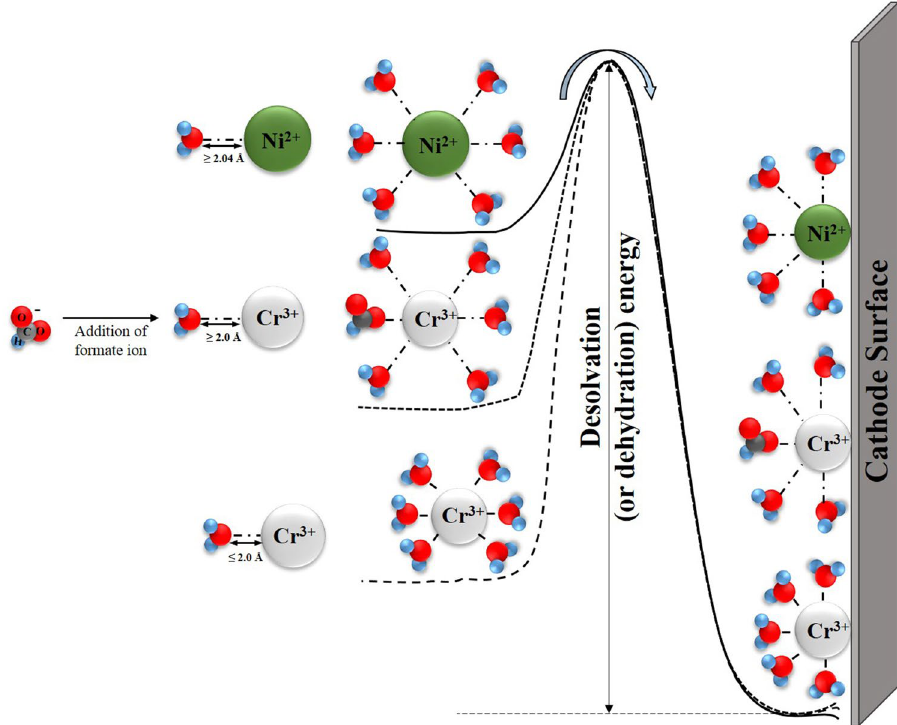
Fig. 2 Schematic representation of desolvation (or dehydration) energy of [Ni(H 2 O) 6 ] 2+ solvated ion denoted by solid line; of [Cr(H 2 O) 5 HCOO] 2+ solvated ion denoted by dotted line; and of [Cr(H 2 O) 6 ] 3+ solvated ion denoted by dashed